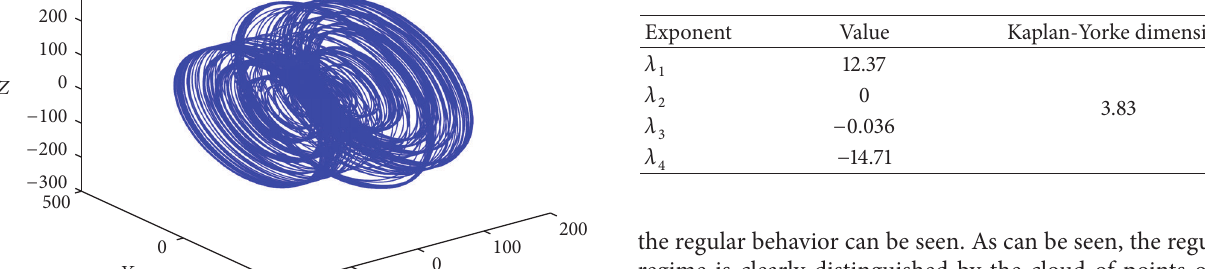
Table 4: Lyapunov exponents study for the hyperchaotic